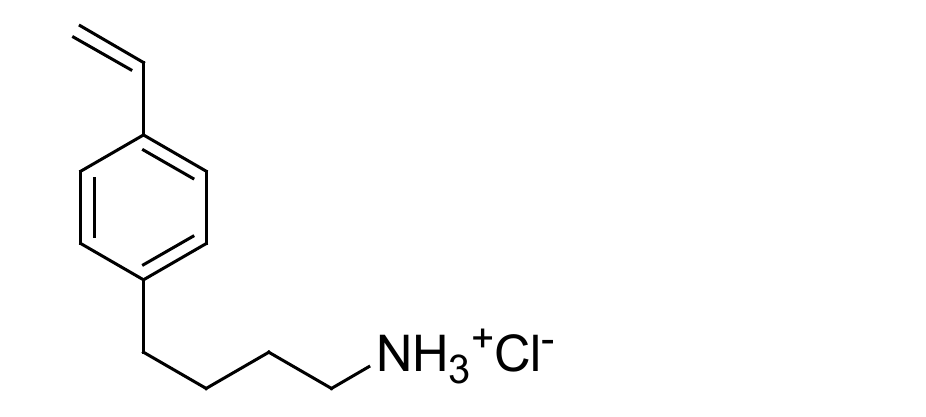
Figure 1. Structure of 4-AMBSTY HCl (M4).